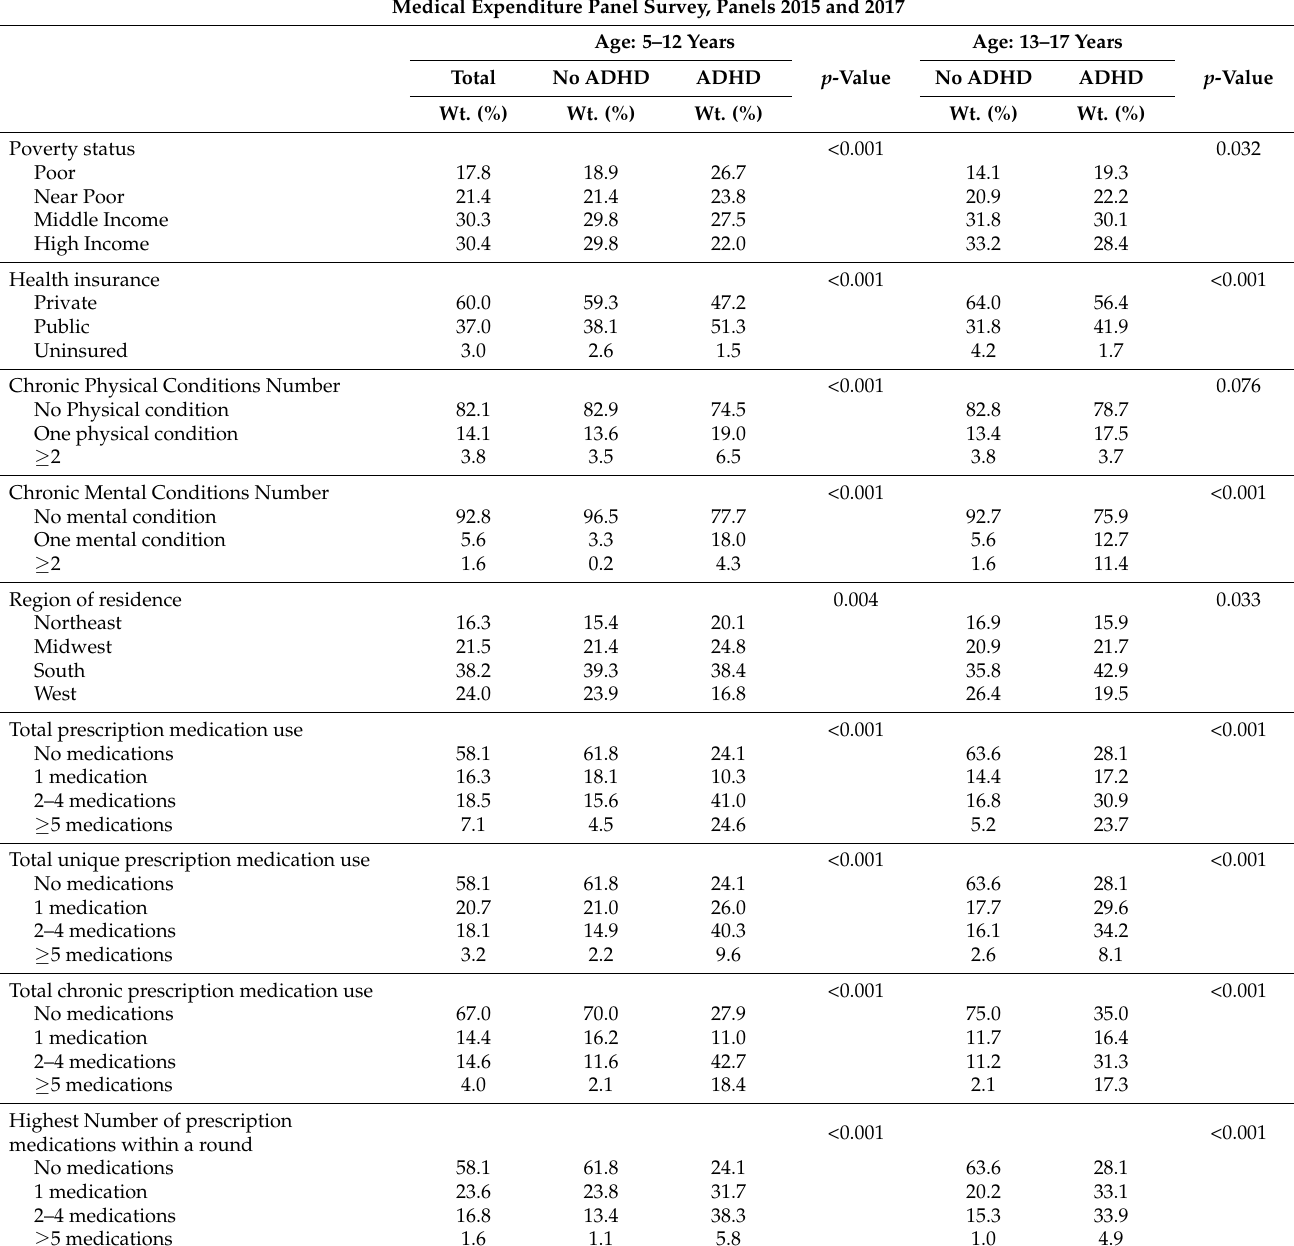
Table 1. Cont. Weighted Percentages Medical Expenditure Panel Survey, Panels 2015 and